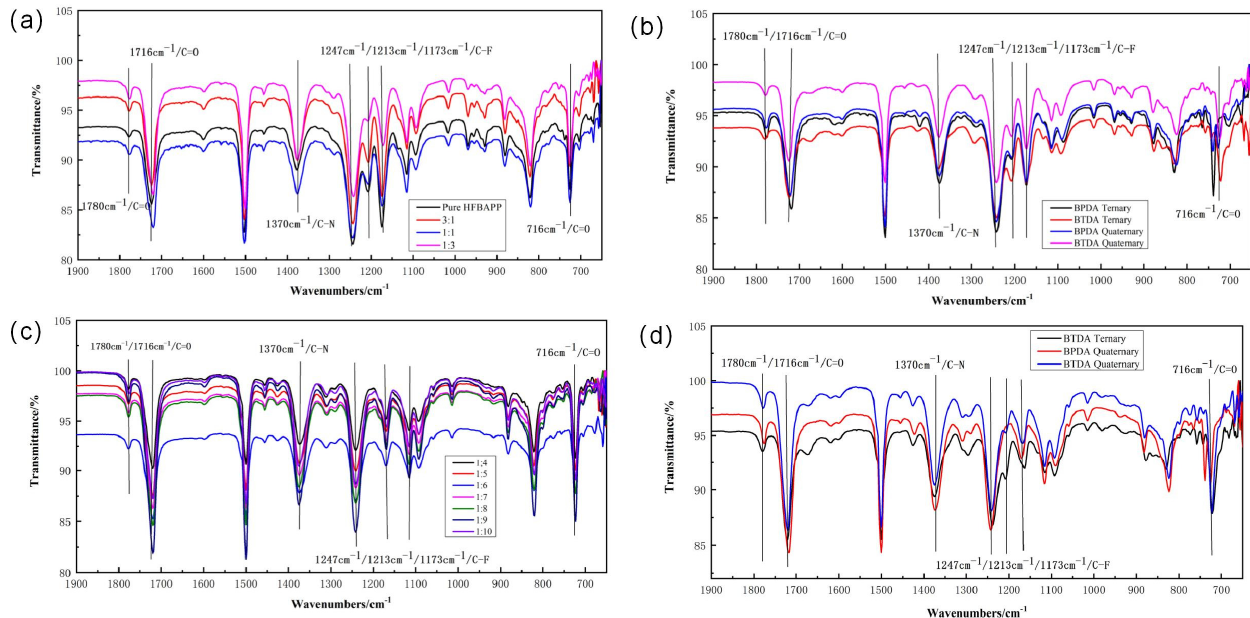
Figure 6. FTIR spectra of fluorinated PI films ( a ) FTIR spectra of group HFOP; ( b ) FTIR spectra of group HFOB; ( c ) FTIR spectra of group TFOP; ( d ) FTIR spectra of group TFOB.